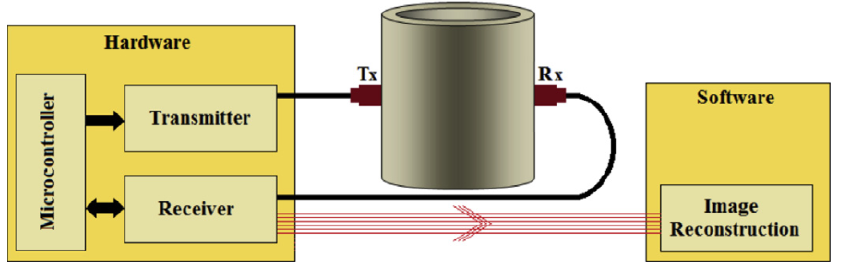
Figure 10. Block diagram of an ultrasonic tomography system